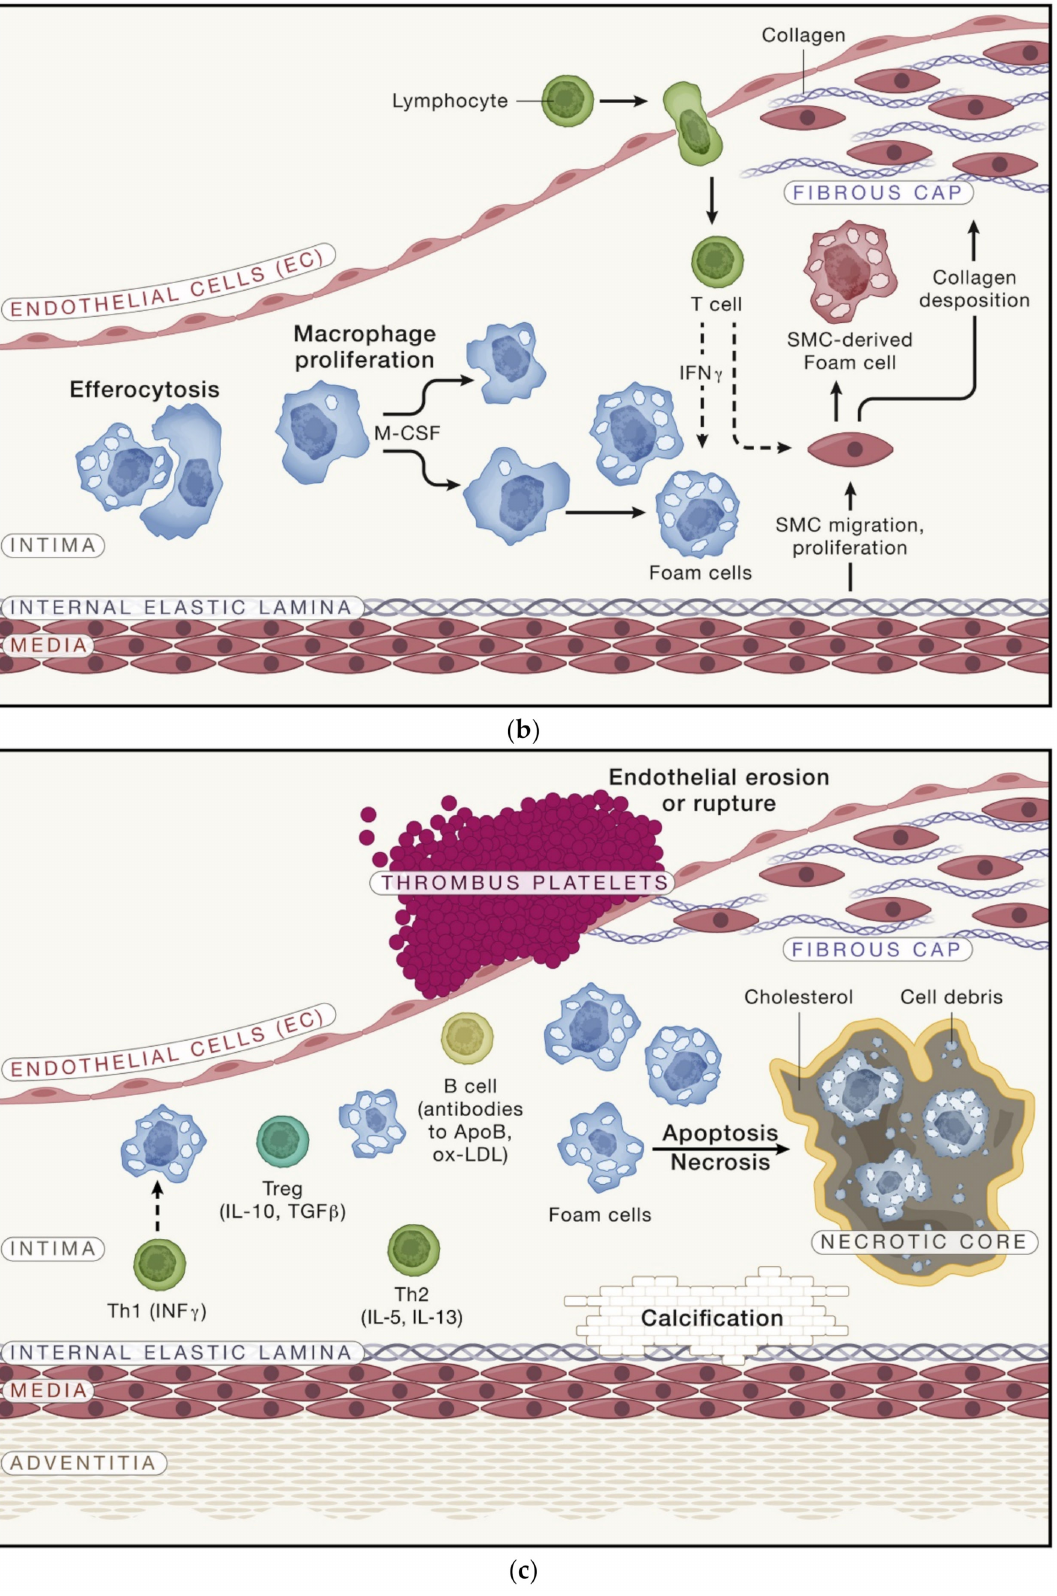
Figure 1. Stages of development of atherosclerotic lesions: ( a ) development of fatty streak lesions; ( b ) development of atherosclerosis lesions; ( c ) advanced atherosclerotic lesions (Figure 1 is taken from the work Björkegren and A.J. Lusis